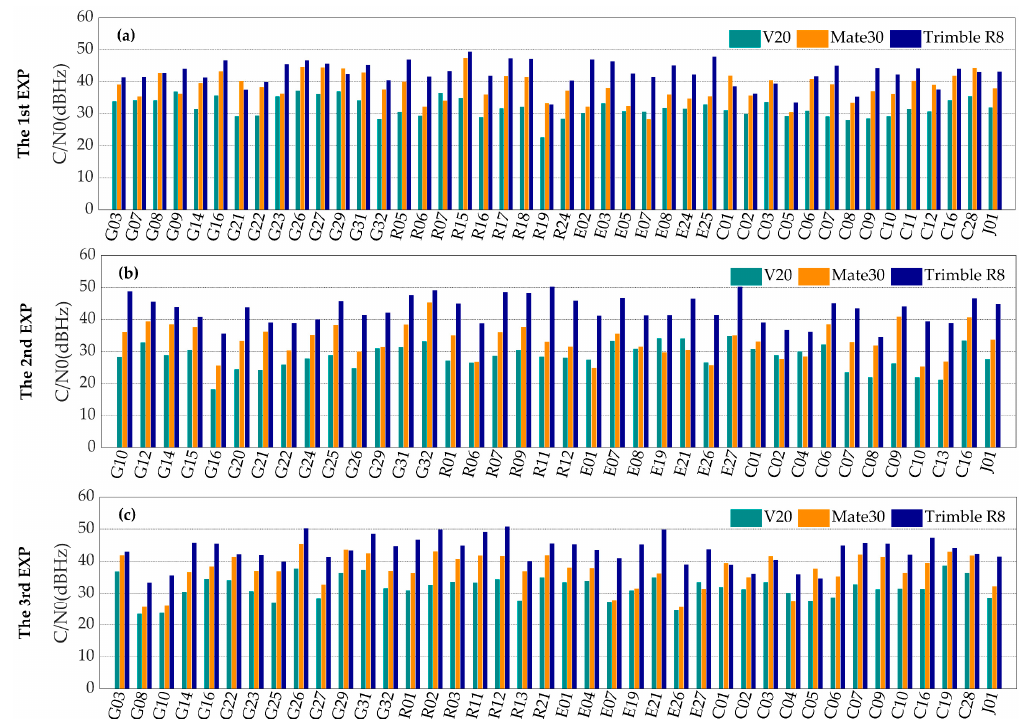
Figure 6. The mean carrier-to-noise ratios of the first frequency with the V20 smartphone (cyan), the Mate30 smartphone (orange) and the geodetic receiver Trimble R8 (blue) in the first ( a ), the second ( b ) and the third ( c ) experiments.